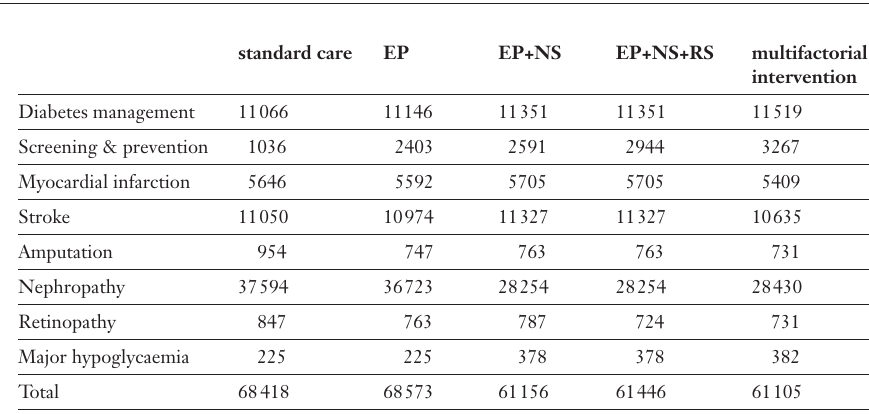
Discounted and undiscounted mean life expectancy (LE) (years) and total life- time costs (TC) (CHF in 1996 values) per type 2 diabetes pa- tient with and with- out interventions.